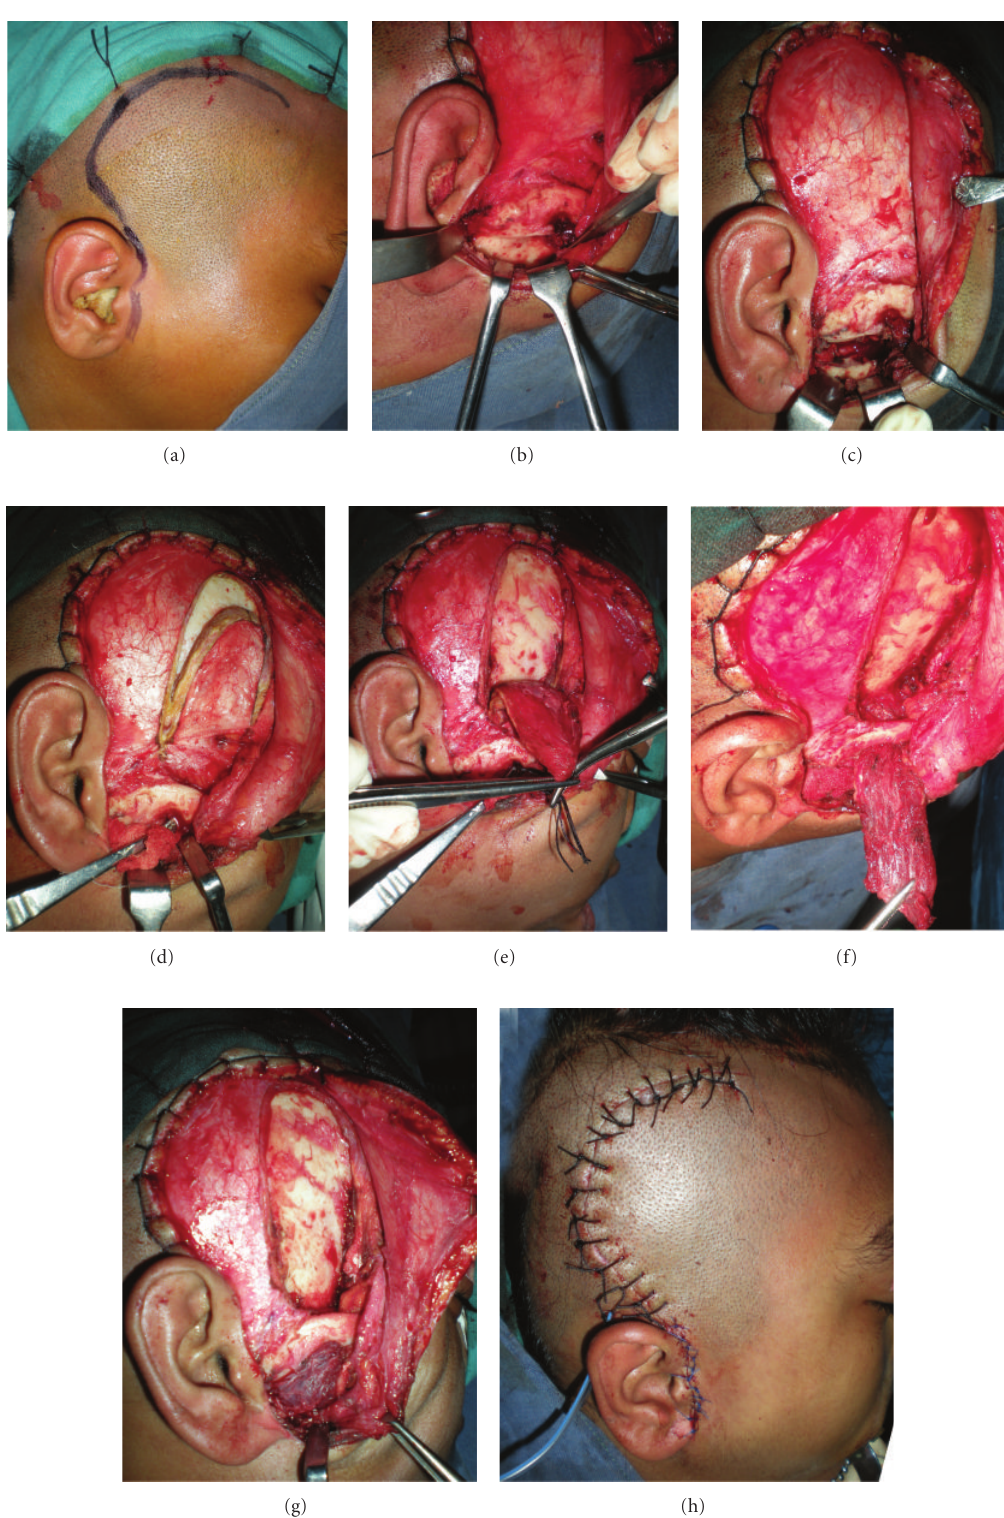
Figure 2: (a)–(h) gap arthroplasty and temporalis graft interpositioning through preauricular